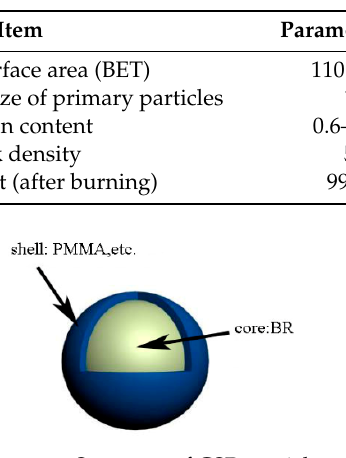
Table 2. The major parameters of nano-SiO 2 particles.